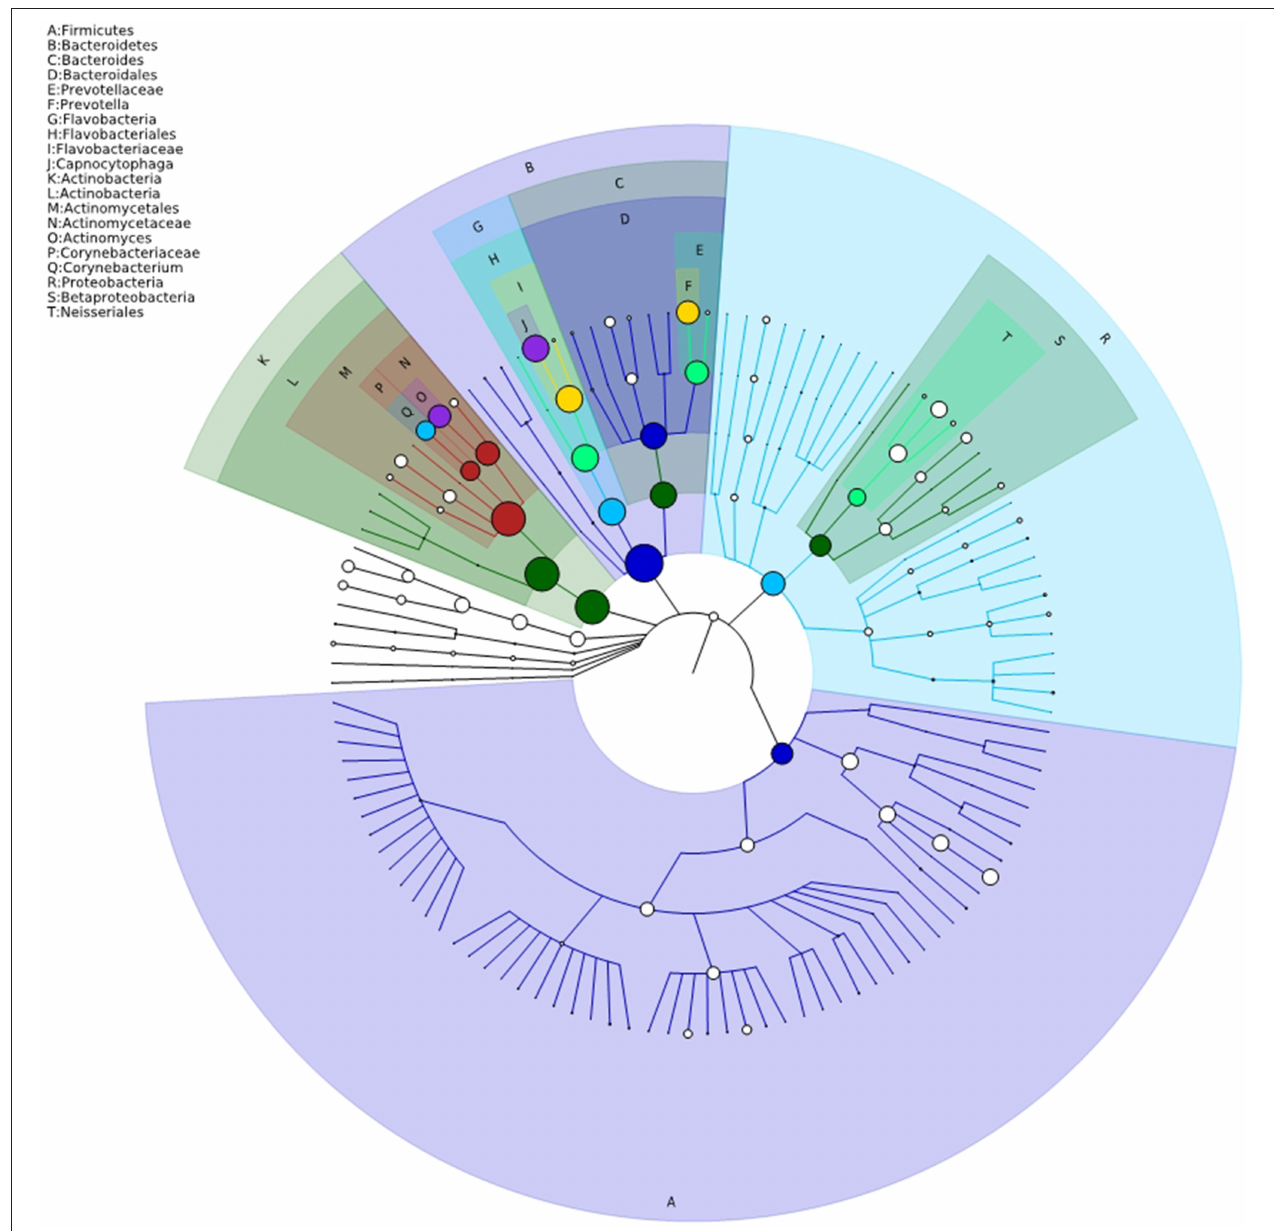
FIGURE 3 | Taxonomy visualization. A taxonomy tree visualized by GraPhlAn. The background color of the letter is consistent with the color of corresponding node. The colored nodes from the inner to the outer circles represent the top 20 abundant taxa from the phylum to genus level, which are signified by the letters arranged from the outer to the inner